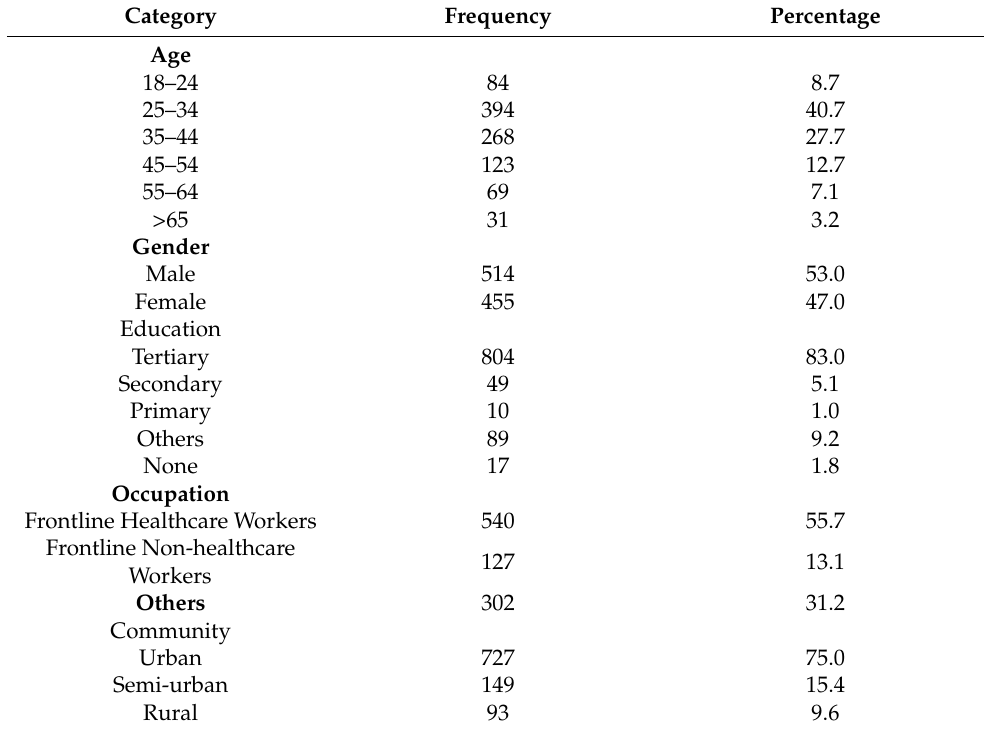
Figure 3. Distribution of some Africans vaccinated against COVID-19 living in the diaspora. Table 2. Demographic distribution of Africans vaccinated for